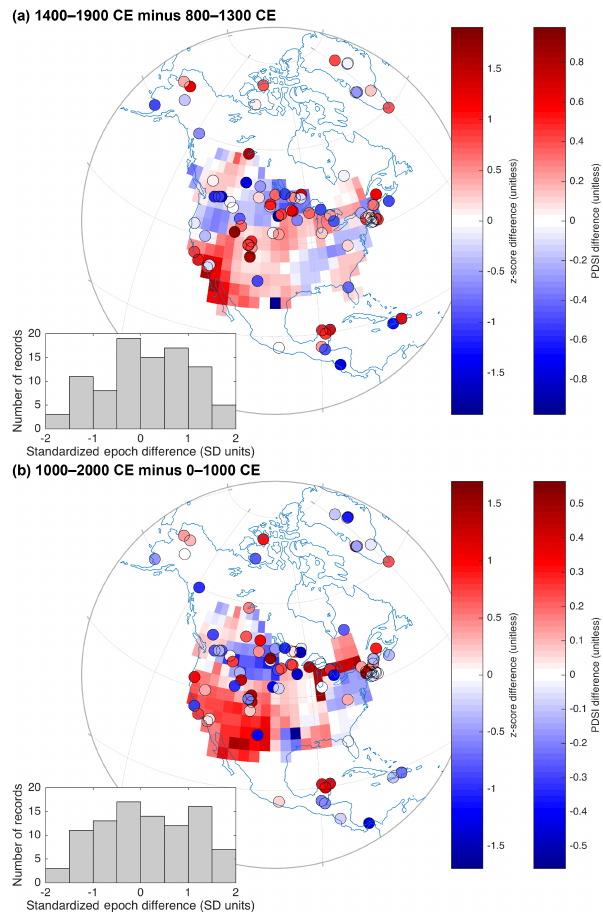
Figure 5. Epoch differences showing (a) the average of the Lit- tle Ice Age (1400–1900CE) minus the average of the Medieval Climate Anomaly (800–1300CE), and (b) the average standard- ized value (in SD units) of the second millennium (1000–2000CE) minus the average of the first millennium (0–1000CE). Red sym- bols indicate that the older interval (epoch) was drier than the younger interval; blue symbols indicate the opposite. Circles show the datasets used here for comparison with the gridded North Amer- ican Drought Atlas Palmer Drought Severity Index (PDSI) differ- ences (Cook and Krusic, 2008); the right scale bar applies to the PDSI data. Histograms below show the total distribution of differ- ences for each epoch from the dataset presented in this paper; both are skewed positively toward the older interval being drier than the younger